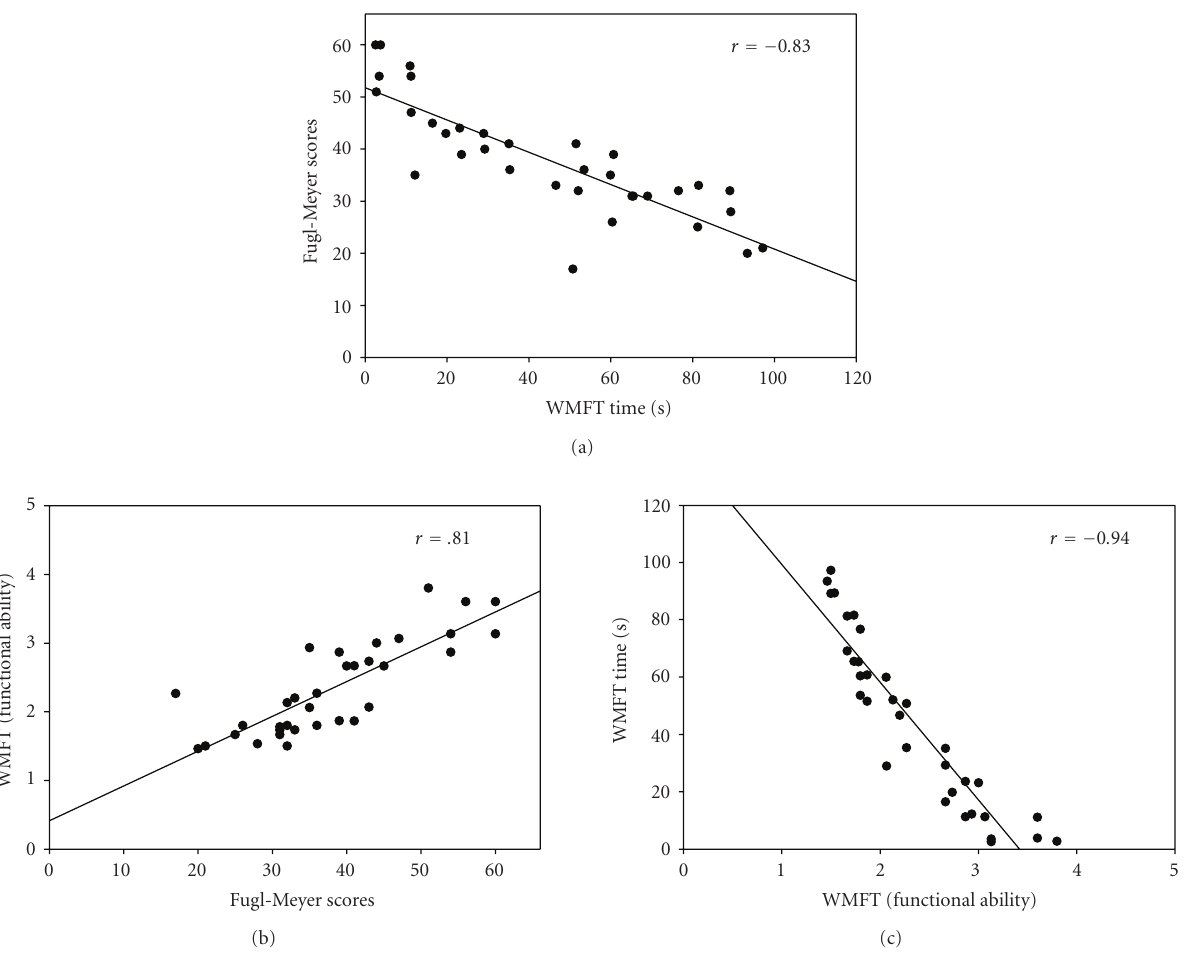
Figure 2: The correlations between the dependent measures (WMFT functional ability and time scores and the FM). The associations were all strongly associated and were significant at P < . 01.